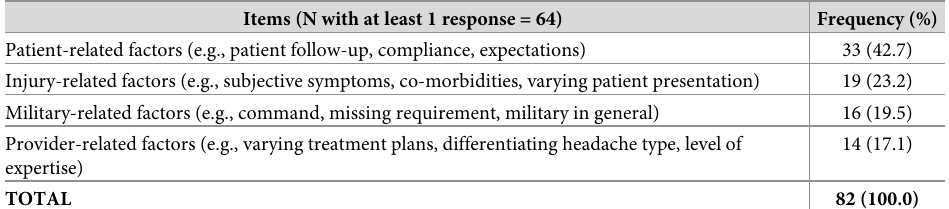
Table 8. Challenges in providing care to patients with post-traumatic headaches post-concussion. Items (N with at least 1 response =